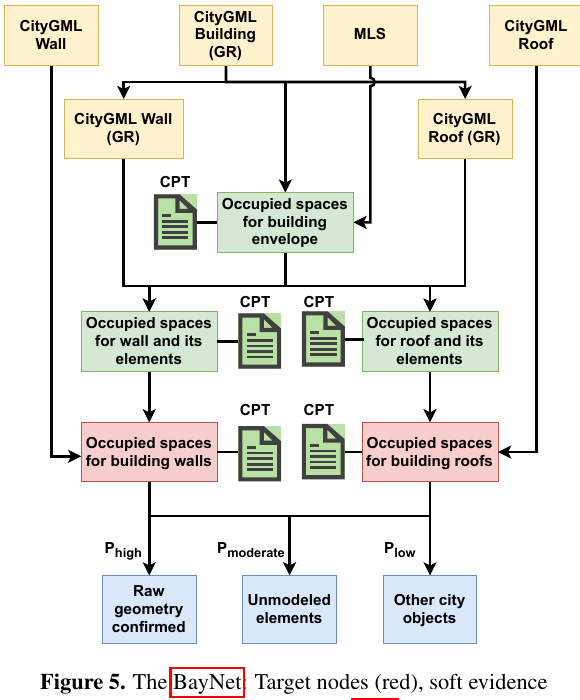
Figure 5. The BayNet: Target nodes (red), soft evidence (yellow), and nodes (green) with CPT. GR stands for generalized range of city model with associated